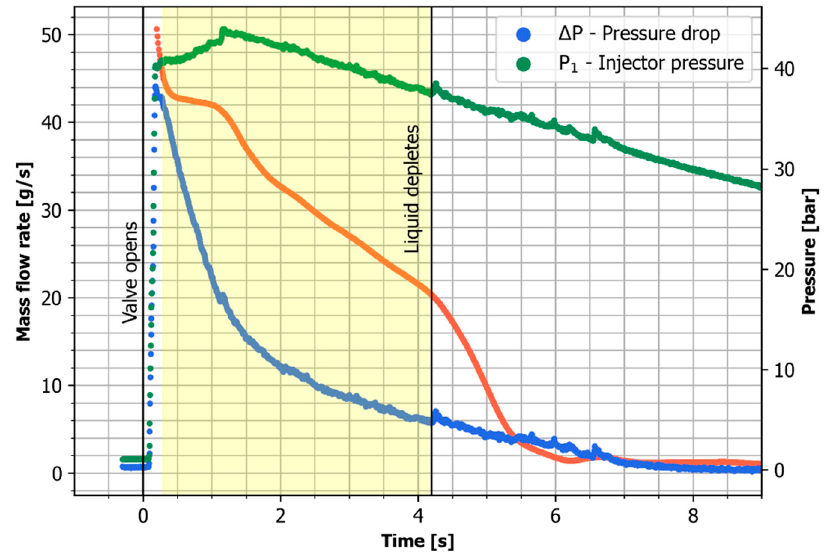
Figure 7. Injector pressure drop ∆ P and vapor pressure P 1 plotted with mass flow rate (red) calculated from the mass measurement. Liquid depletion is identified by the sudden drop of the mass flow rate. The yellow region shows relevant data trimming for the analysis. Data for the Injector No. 2.